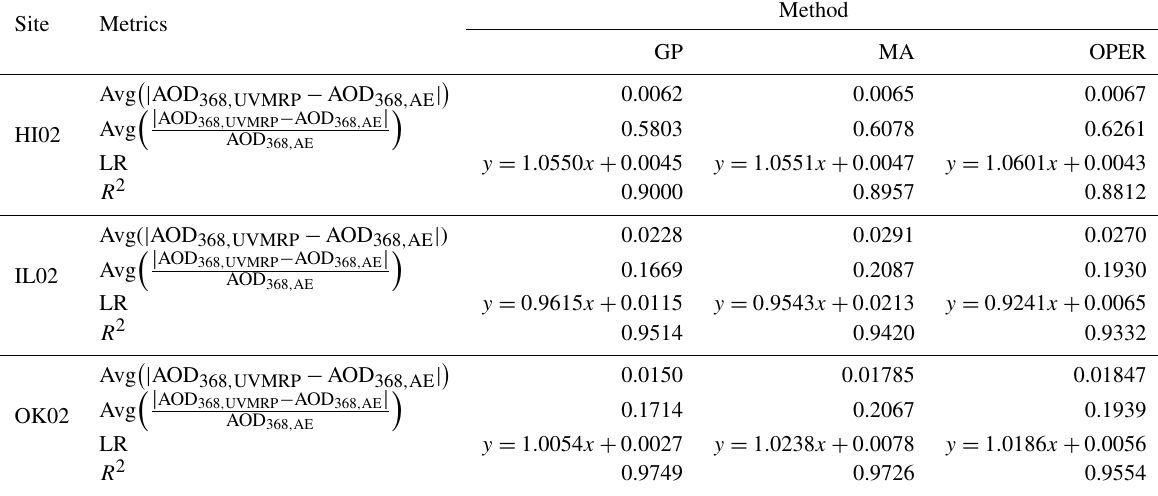
Table 3. Statistical metrics (average absolute difference, average absolute relative difference, and linear regression) on comparing 368nm AOD between UVMRP (AOD 368 , UVMRP ) and AERONET (AOD 368 , AE ). The UVMRP 368nm AODs at the three sites (i.e., HI02, IL02, and OK02) are calculated using calibration factors estimated using the three methods (i.e., GP, MA, and OPER). The AERONET 368nm AODs are derived from collocated (i.e., Mauna_Loa, BONDVILLE, and Cart_Site) AERONET AODs on the 340 and 380nm channels. LR stands for linear regression. R 2 stands for the coefficient of determination for linear regression. The “ x ” and “ y ” in LR refer to AOD 368 , AE and AOD 368 , UVMRP of the respective